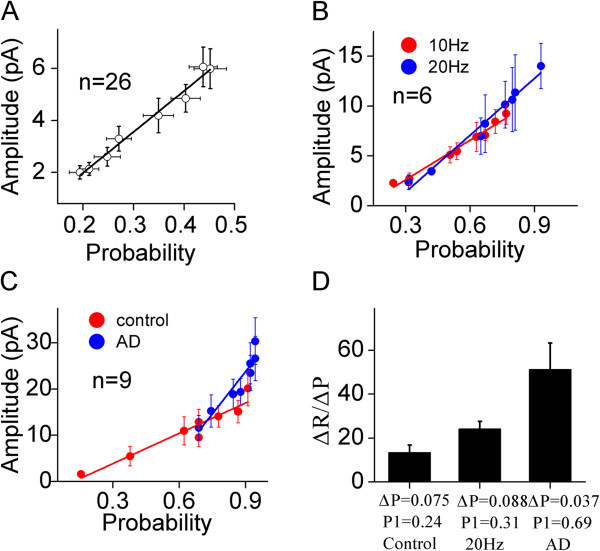
Presynaptic Ca2+ enhances an efficiency of probability-driven facilitation. A) shows a linear correlation between the probability of releasing glutamate and the amplitude of unitary synaptic responses (uEPSCs). B) shows the comparisons of linear correlations between release probability and uEPSCs induced by eight spikes at 10 Hz (red symbols) and 20 Hz (blues, n = 6). The efficiency of probability-driven facilitation is high when presynaptic spikes are 20 Hz. C) shows the comparisons of linear correlations between release probability and uEPSCs induced by eight spikes under control (red-filled symbols) and adenophostin-A infusion (blues, n = 9). The efficiency of probability-driven facilitation is high when presynaptic Ca2+ is elevated by AD infusion. D) A plot shows the ratios of changes in uEPSCs to release probability vs. the levels of release probability, i.e., the higher release probability is, the higher efficiency of probability-driven facilitation. Lines in A ~ C illustrate linear dynamical fitting.